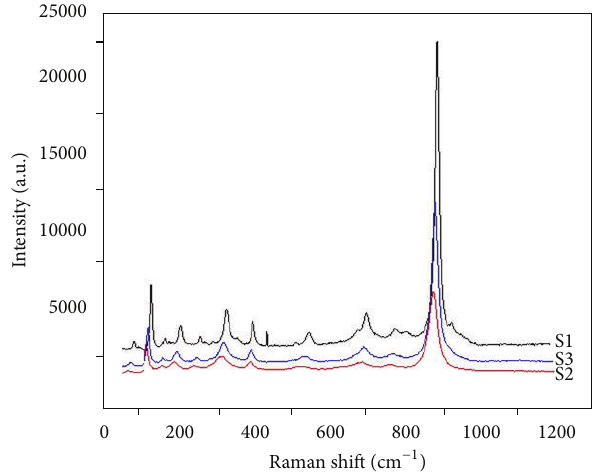
Figure 6: Raman spectra of MnWO 4 samples.